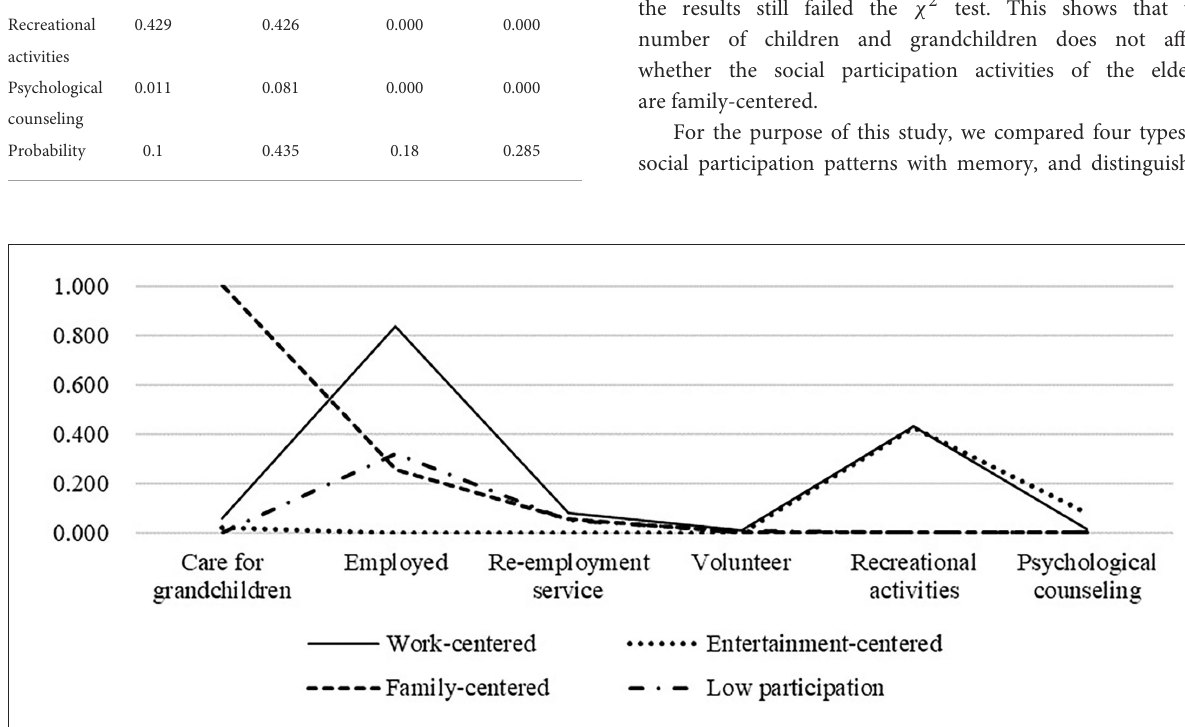
FIGURE4 Conditional probability distribution of the four social participation patterns ( N =